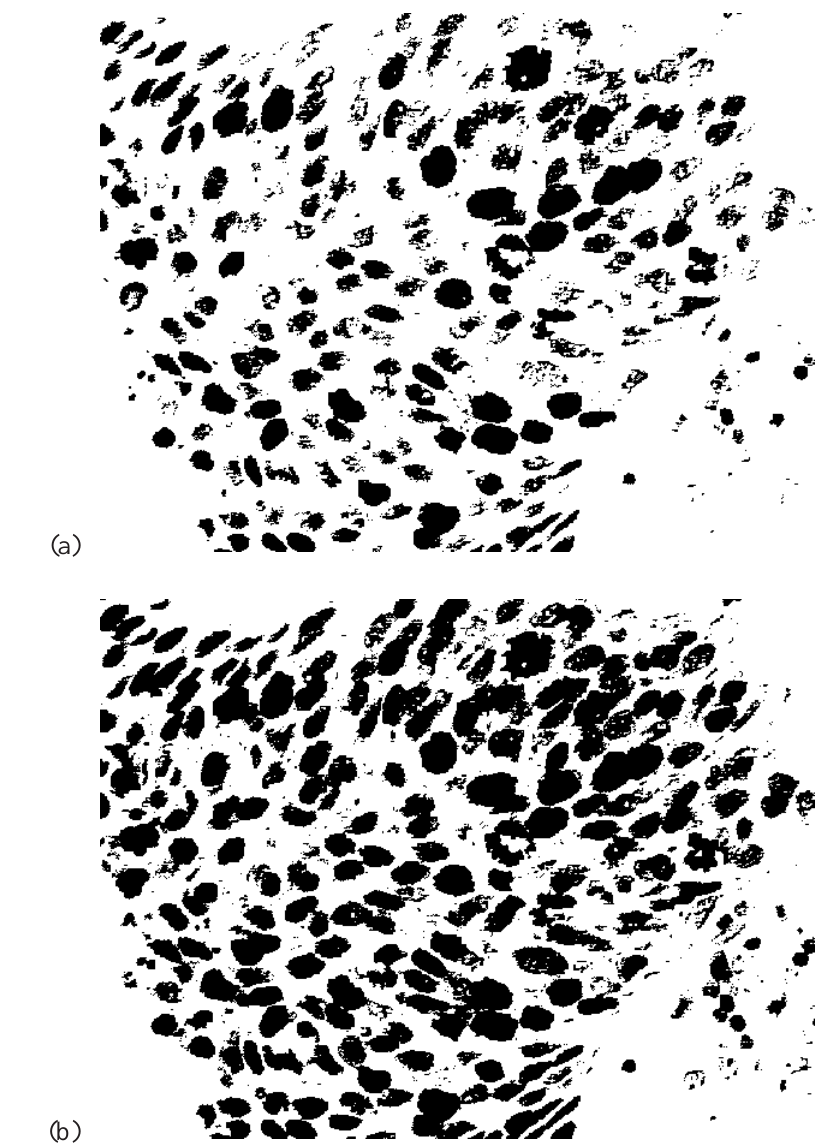
Fig. 4. Threshold for Fig. 1(a) at the left maximum, the minimum and the right maximum, respectively, of the P 2 / A - histogram in Fig.